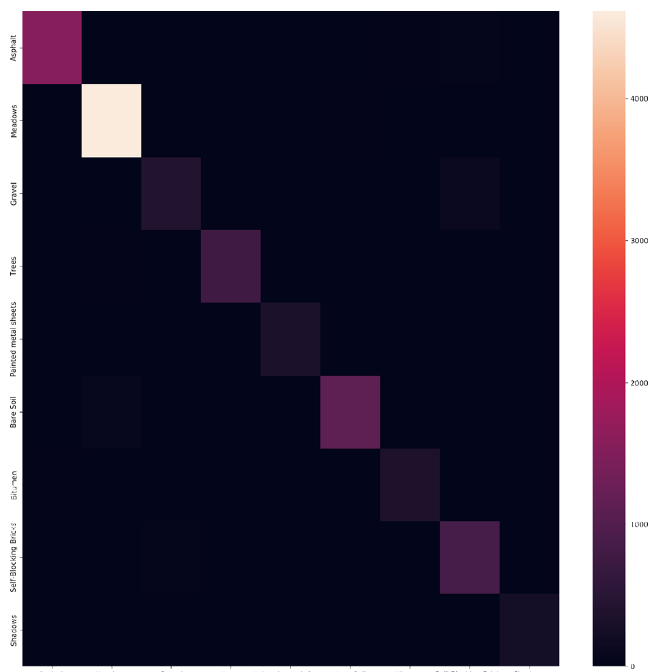
Fig. 11 Pavia University Confusion Matrix for PCA 30 CEU-Net no patching with a 75%/25% Training/Testing